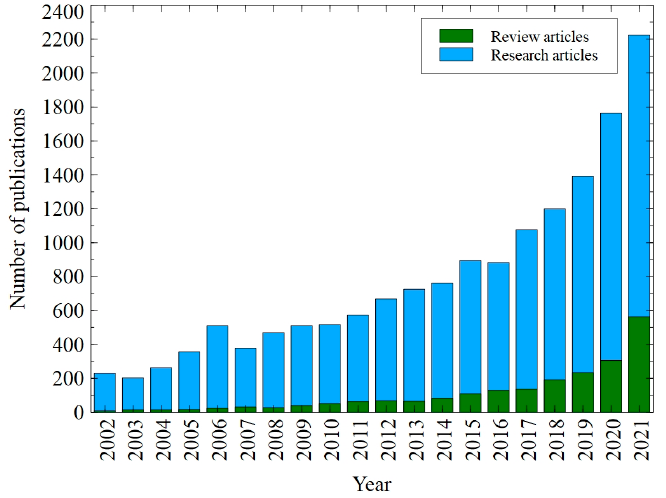
Figure 2. The number of papers focused on nanofiltration according to Science Direct. Keywords: nanofiltration + fermentation broth, data retrieved: 11 October 2022.